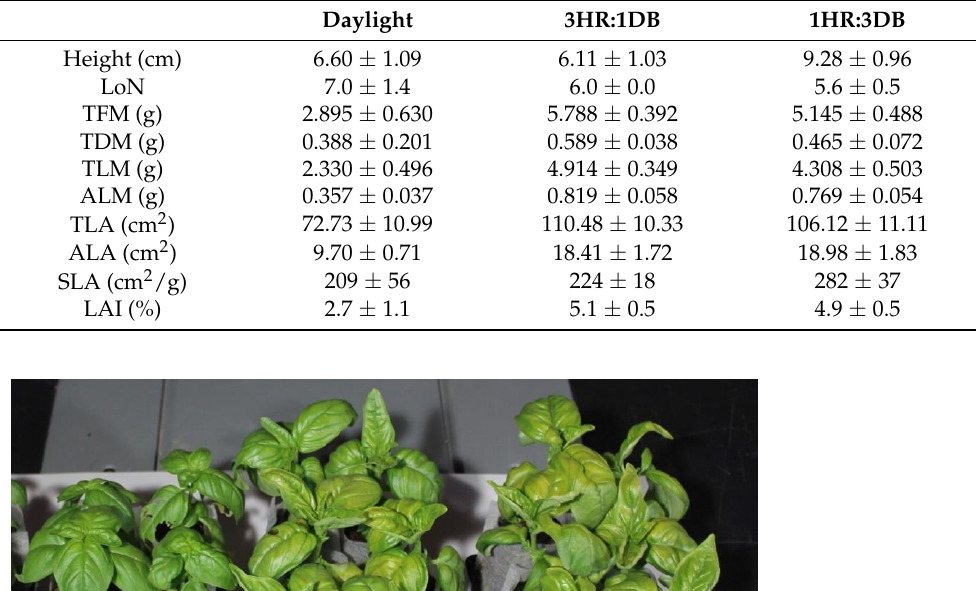
Table 5. Growth performance for basil plants under different lights.